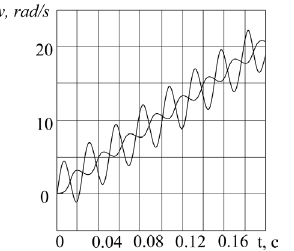
Fig. 9. The angular velocities of the first and second masses without the gaps of the mechanical